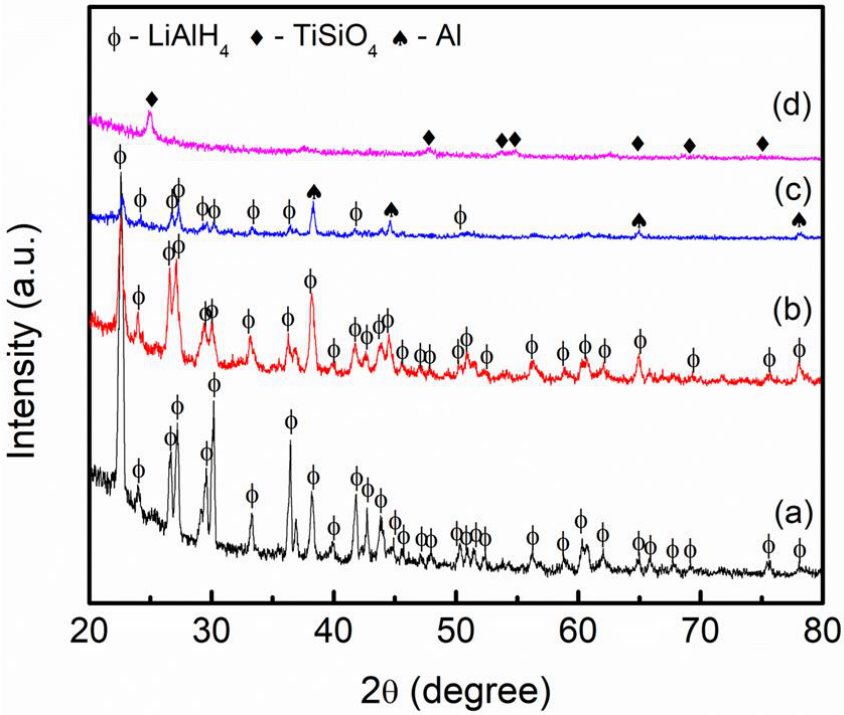
Figure 6. XRD results of ( a ) as-obtained LiAlH 4 , ( b ) post-milled LiAlH 4 , ( c ) LiAlH 4 added with 10 wt% of TiSiO 4, and ( d ) as-obtained TiSiO 4 .